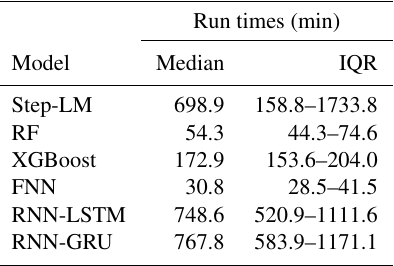
Table 5. Run times of all applied ML models given as the median and inter-quartile ranges (IQR) of run times in